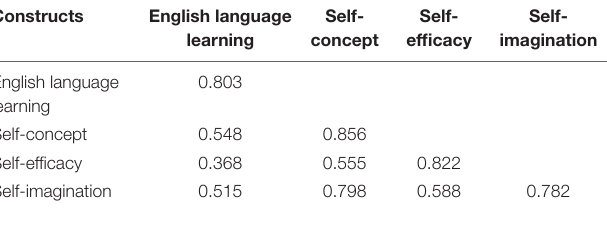
TABLE 3 | Discriminant